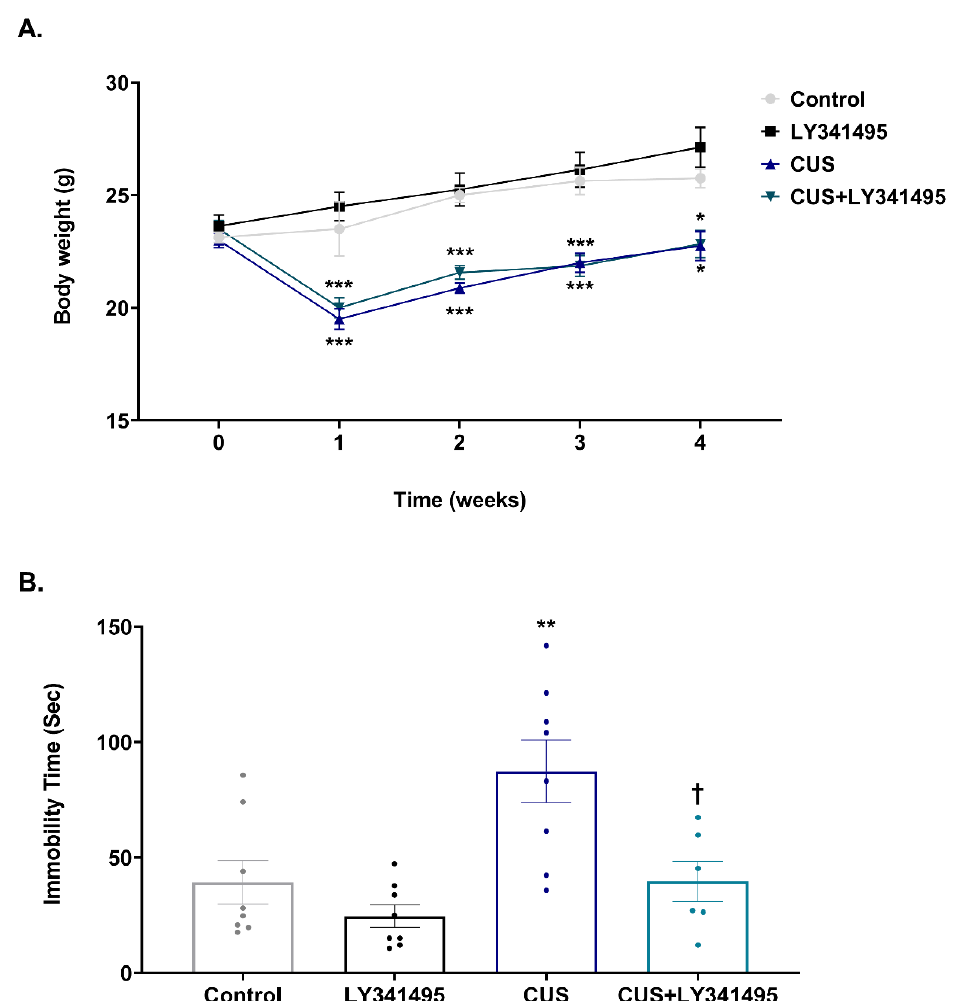
Figure 1. Antidepressant-like effects of chronic LY341495 administration in chronic unpredictable stress (CUS)-exposed mice, as indicated by the forced swimming test (FST). Mice were treated daily with LY341495 (1 mg/kg) or vehicle (1 mL/kg, 0.9% saline) with (the CUS and CUS + LY341495 groups) or without (the control and LY341495 groups) CUS for 4 weeks. Body weight ( A ) was measured every week for 4 weeks. The FST immobility time ( B ) was measured 24 h after the last CUS session. The control (non-stressed mice that received the vehicle), LY341495 (non-stressed mice that received LY341495), CUS (stressed mice that received the vehicle), and CUS + LY341495 (stressed mice that received LY341495) groups were compared. Values are expressed as mean ± SEM. * p < 0.05 vs. the control group, ** p < 0.01 vs. the control group, *** p < 0.001 vs. the control group; † p < 0.05 vs. the CUS